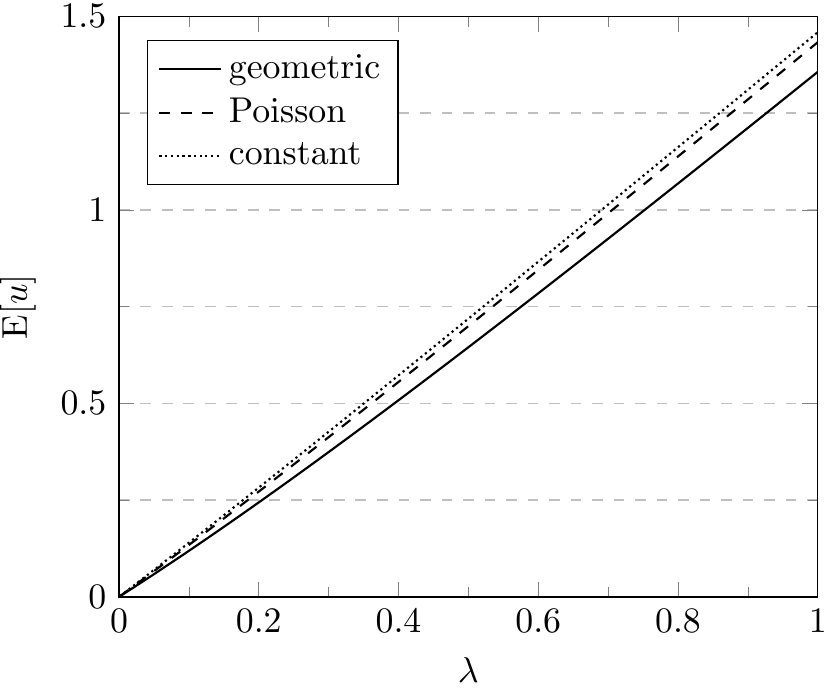
Figure 5. Mean system content E [ u ] versus λ , for Poisson arrivals, σ = 0.4 and various distributions for the service times with S (cid:48) ( 1 ) =